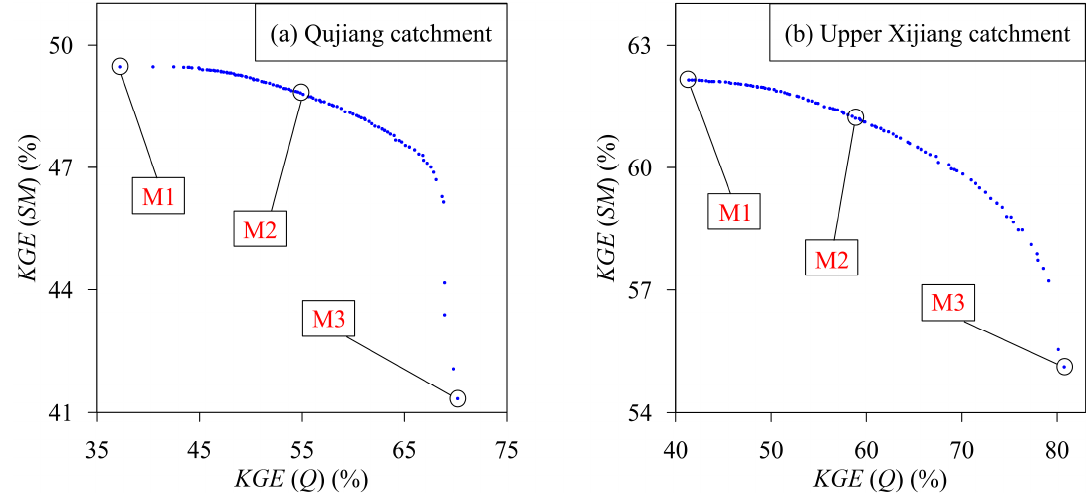
Figure 6. The Pareto front formed from A Multi-algorithm Genetically Adaptive Multi-objective method (AMALGAM) calibration from the warm-up period in Qujiang catchment ( a ) and Upper Xijiang catchment ( b ). The Kling-Gupta Efficiency KGE (%) between observed and model-simulated streamflow ( Q ) ( x -axis) is plotted against KGE (%) between pre-processed satellite and model-simulated soil moisture ( y -axis) as blue plots. The plots in the black circles are used to construct the prior information for residual error model parameters in various calibration scenarios, which are signed as M1–3 for each